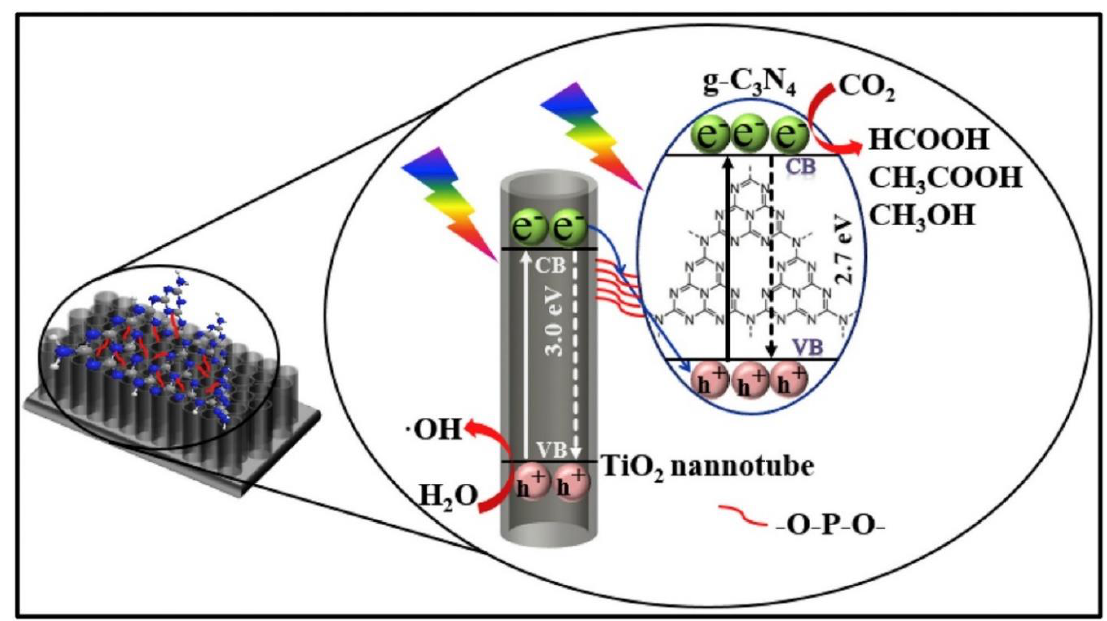
Figure 8. Schematic representation of photogenerated charge transfer and separation mechanism of the built P–O-connected g-C 3 N 4 -TNT composites, adopted from